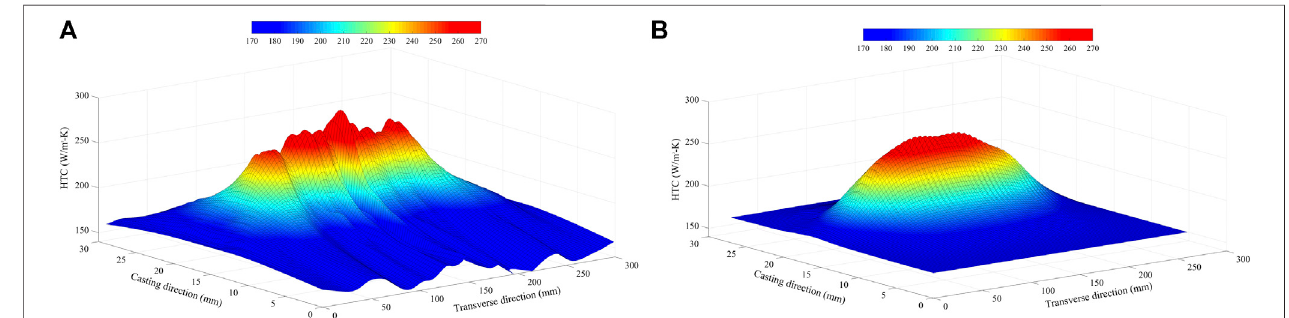
FIGURE 13 | Comparison of HTC distributions (A) CFD-predicted, and (B) correlation-predicted.